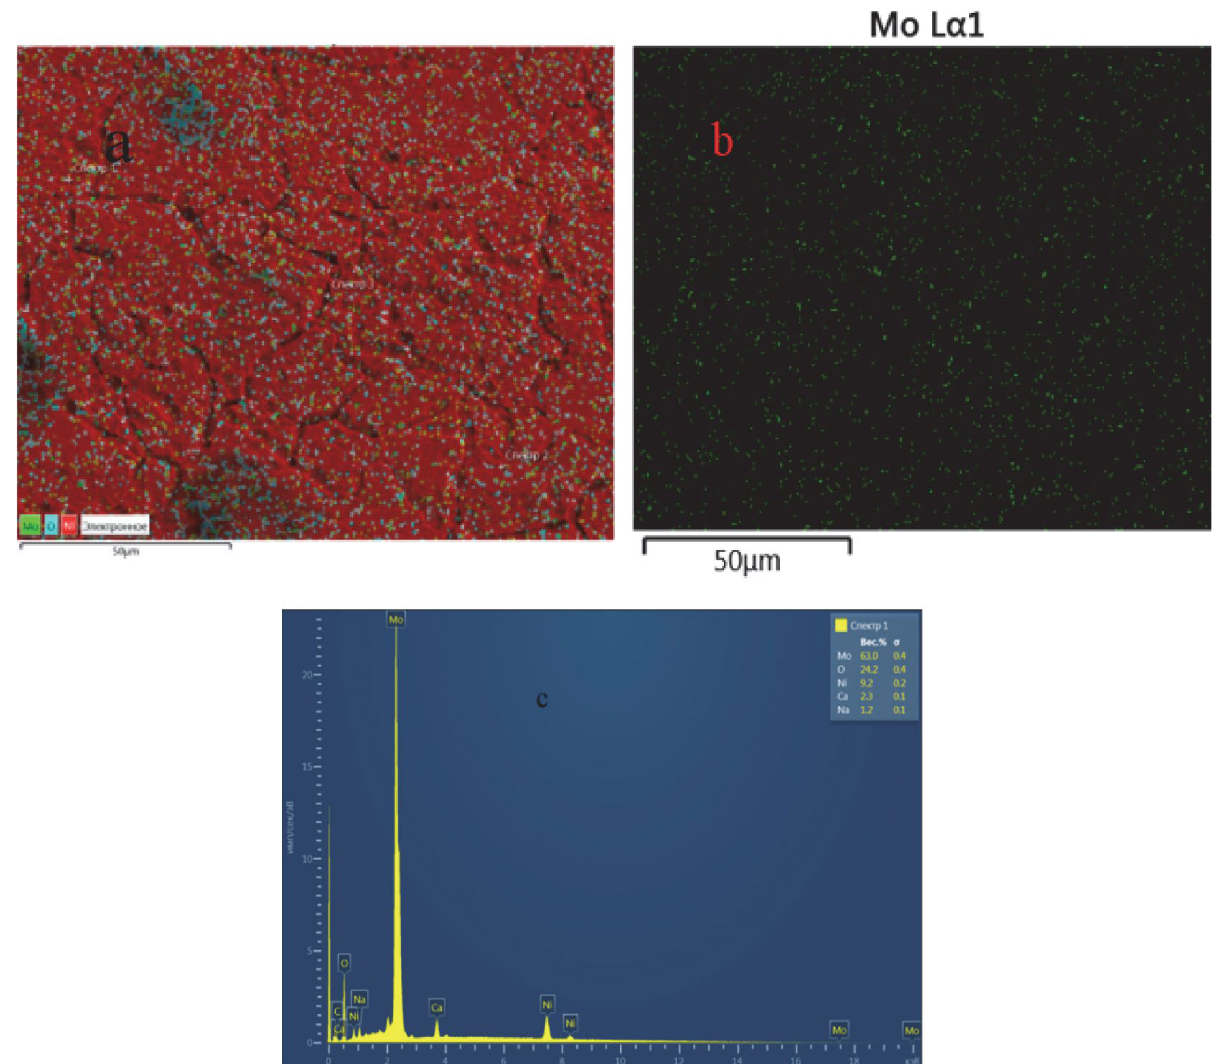
Fig . 9 . SEM (a, b) and EDAX (c) of the electrodeposited Mo from a solution consists of 0,1 M Na 2 MoO 4 2H 2 O + 0.007M C 4 H 6 O 6 at the potential of E = –0.4 V, at scan rate = 0.02 Vs –1 on Ni electrode at T = 295